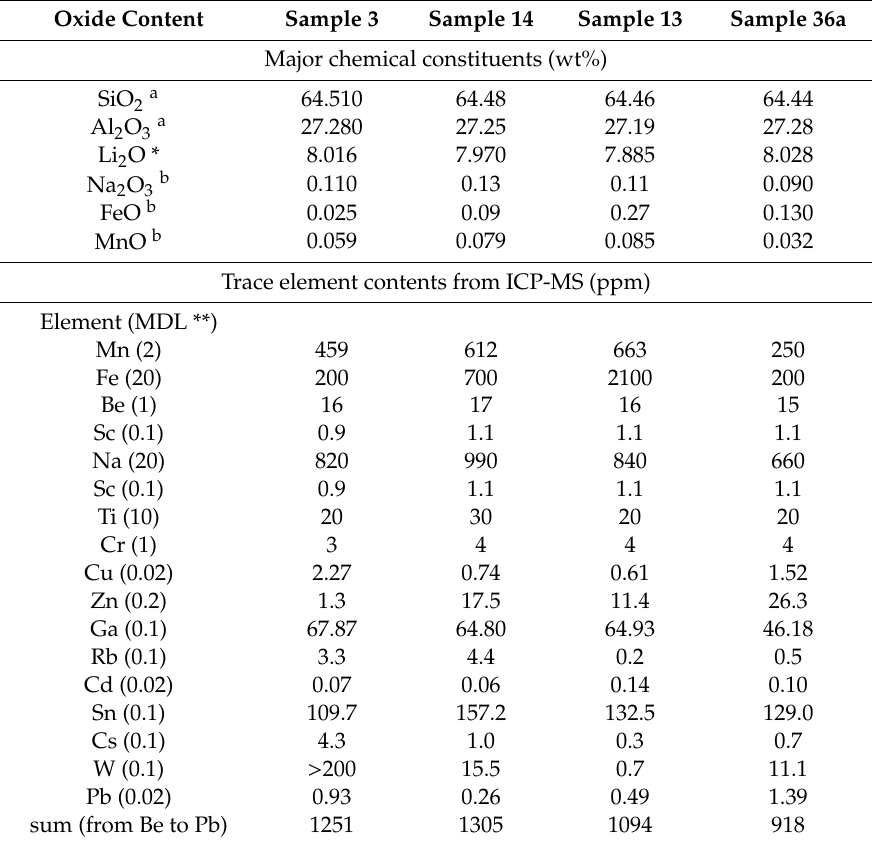
Table 1. The chemical compositions of the studied